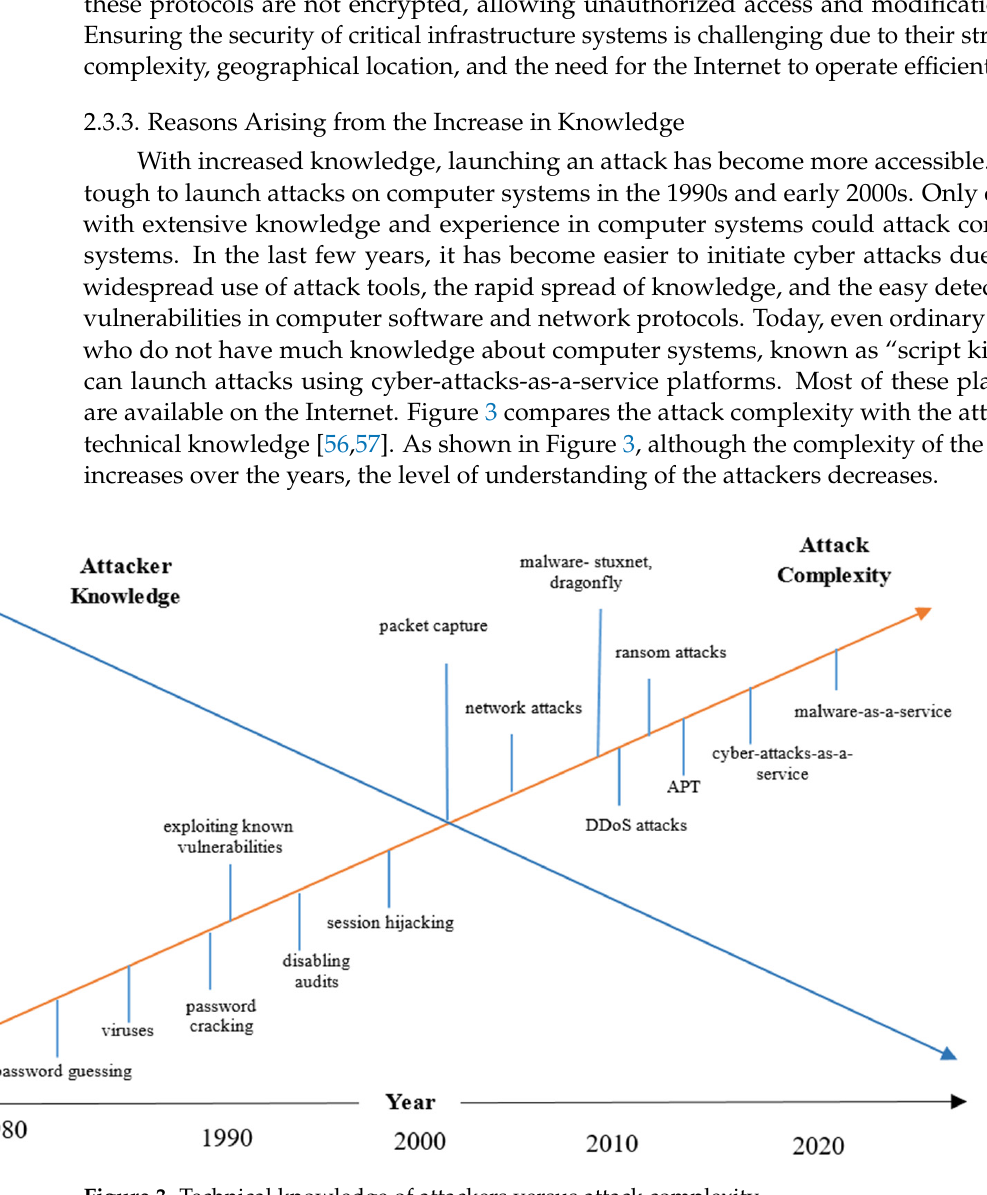
Figure 3. Technical knowledge of attackers versus attack complexity.